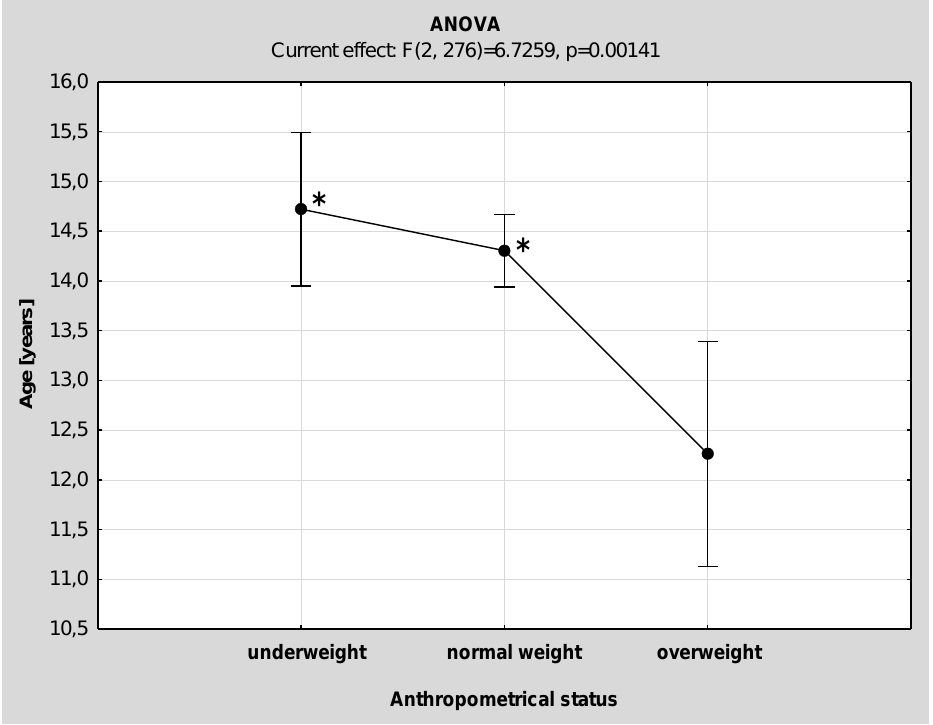
Figure 1. Comparison of chronological age among the anthropometrical subgroups by one-way analysis of variance (ANOVA). * p < 0.01 vs. overweight subgroup.